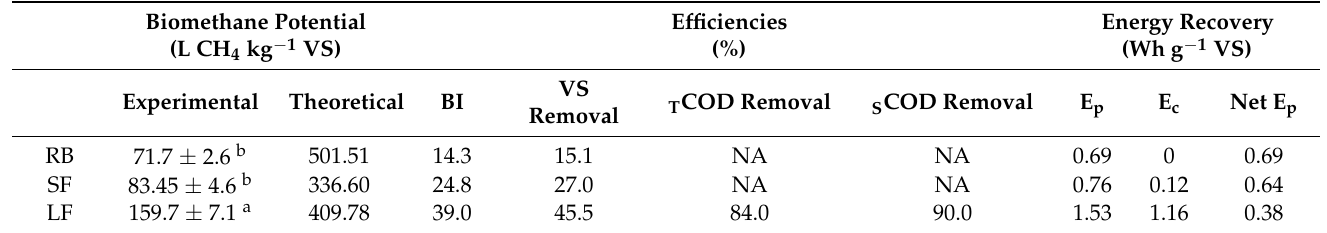
Table 7. Evaluation of anaerobic digestion: biodegradability index, organic matter removal percent- ages, and energy recovery of raw biomass (RB), solid fractions (SF), and liquid fractions (LF). Means with different superscripts indicate statistically significant differences between samples ( p <